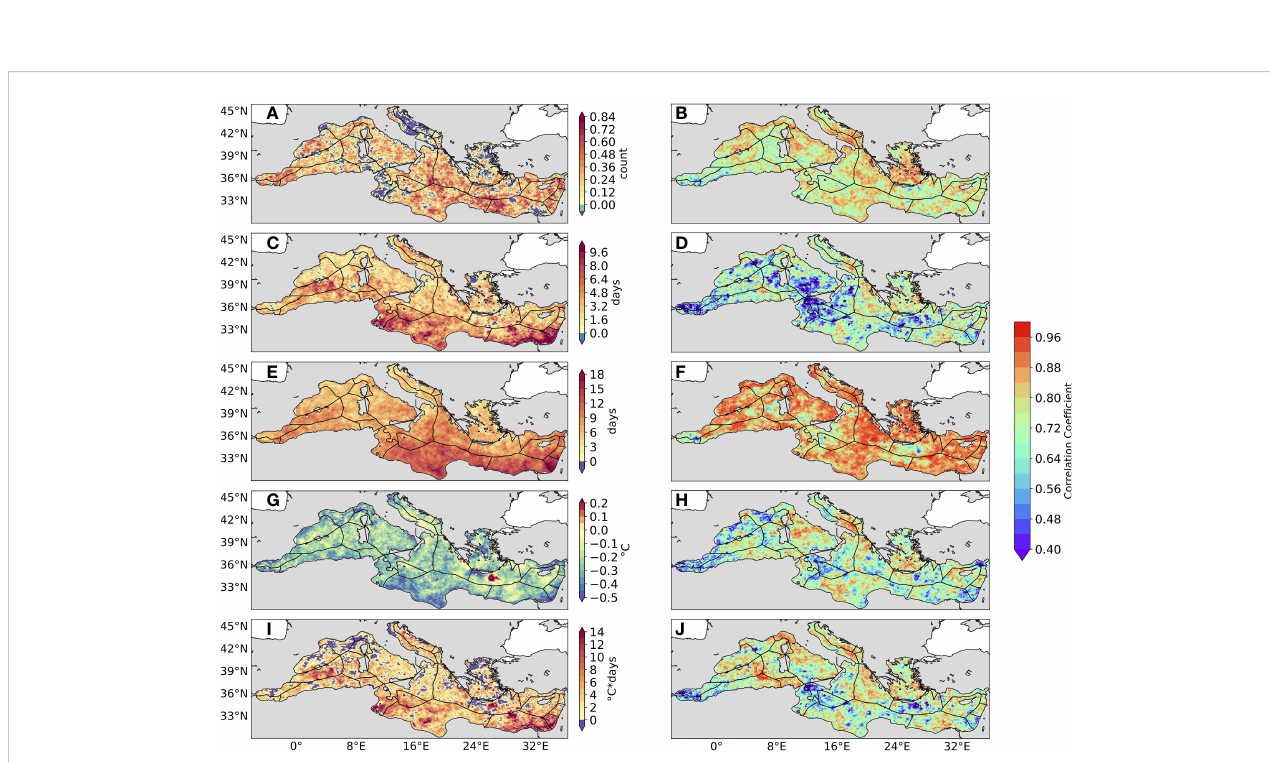
FIGURE 4 (Left panels, A, C, E, G, I ) Difference of the means of surface MHW metrics detected in MEDREA and the one computed from REP over the period 1987- 2019 of annual MHW frequency ( A, in count), duration ( C, in days), total days ( E, in days), maximum intensity ( G, in °C) and cumulative intensity ( I, in ° C*days). (Right panels, B, D, F, H, J ) Pearson Correlation Coef fi cients between surface MHW metrics detected in MEDREA and the one computed from REP over the period 1987-2019 of annual MHW frequency (B) , duration (D) , total days (F) , maximum intensity (H) and cumulative intensity (J) . The black hatches indicate where trend values are not signi fi cant at the 95% con fi dence level based on a Student ’ s